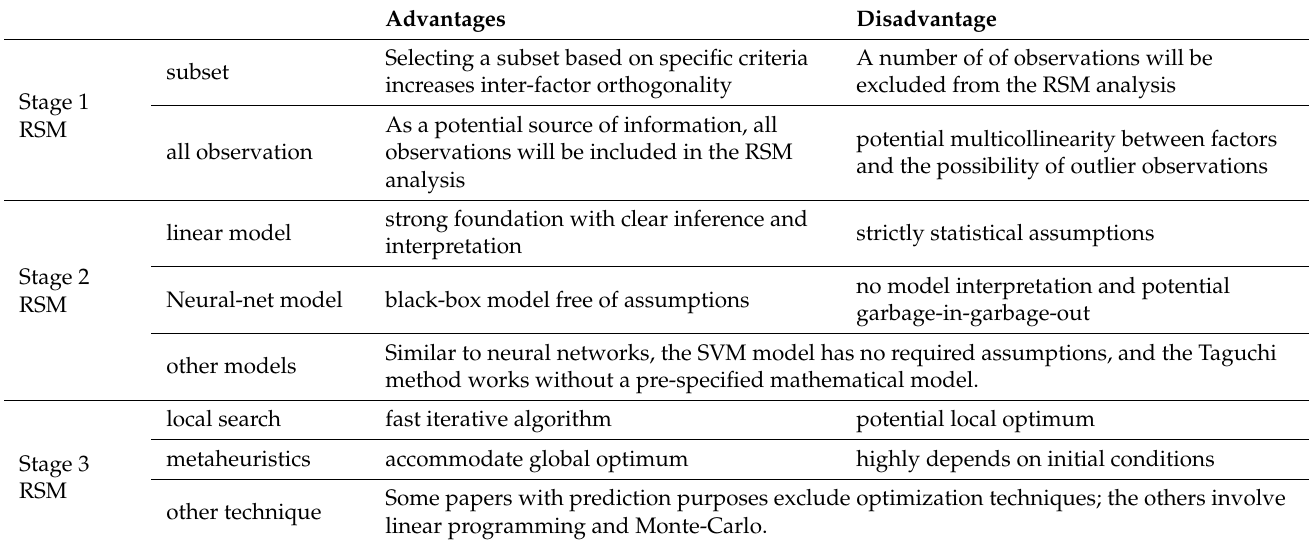
Table 7. Summary of method combinations in consideration of the three stages of